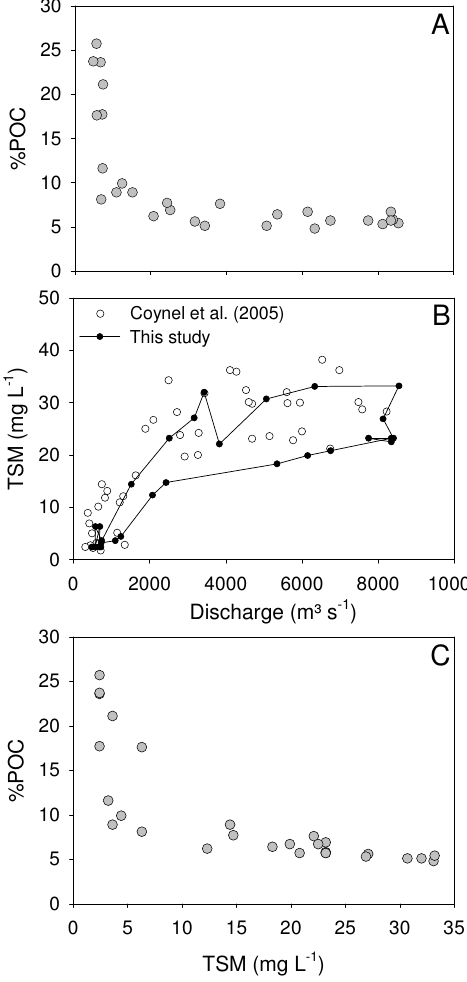
Fig. 4. Seasonal variations of (A) %POC, and (B) TSM, showing hysteresis, with TSM data from this study compared with data from Coynel et al. (2005); and (C) relationship between TSM and %POC. TA varied between 0.234 and 0.600 mmol l − 1 , and showed a strong decrease during high discharge (Fig. 7a). DIC con- centrations ranged from 0.314 to 0.615 mmol l − 1 , following a similar annual cycle. DIC was the dominant C pool during low flow conditions ( ∼ 70 %), but contributed only 20–30 % to the total C pool during high discharge (data not shown). The p CO 2 showed a very strong seasonality, from values close to atmospheric equilibrium during low-flow conditions (470 ± 203 ppm for Q< 1000 m 3 s − 1 , n = 10) to a maximum of 3750 ppm during the first stage of peak discharge (Fig. 7a). CO 2 undersaturation was observed on two of the sampling days (248 and 227 ppm). Given the relatively low variabil- ity in average daily wind speed (1.26 ± 0.61 m s − 1 ) and wa- ter temperature, estimated CO 2 fluxes across the water–air atmosphere based on the parameterization of Raymond and Cole (2001) closely correlated with p CO 2 values and